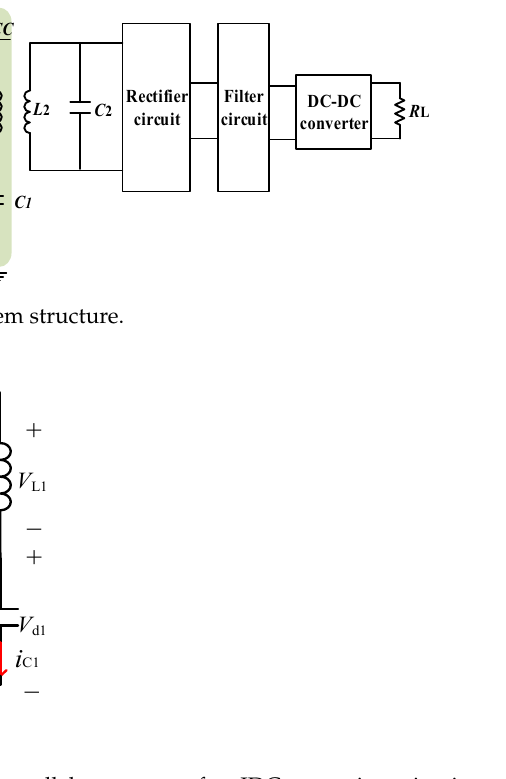
Figure 1. Block diagram of system structure.